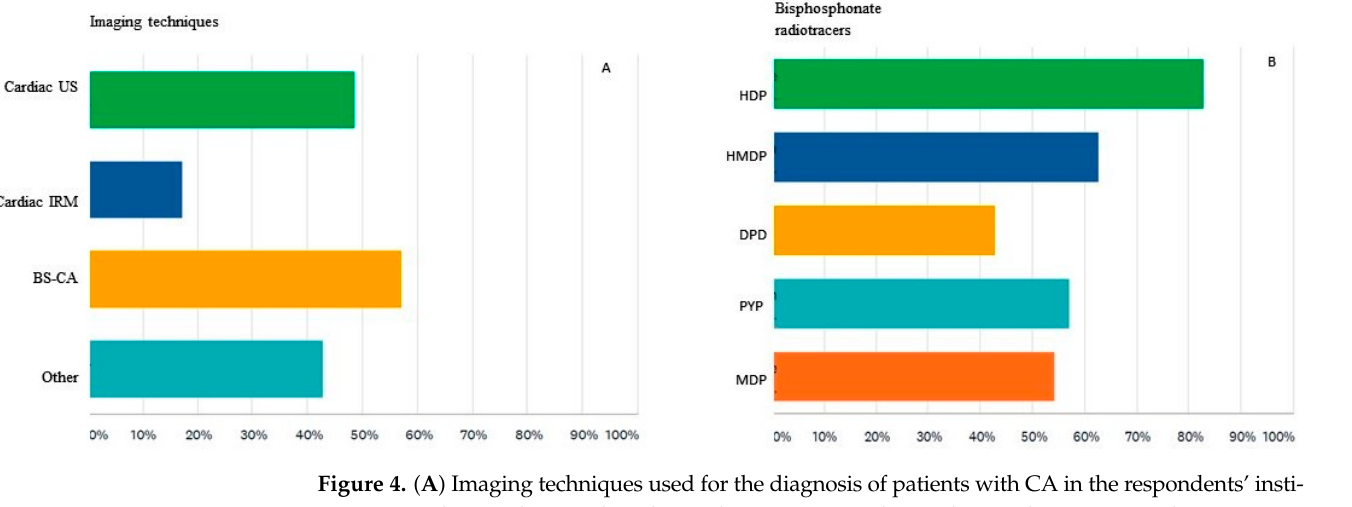
Figure 4. ( A ) Imaging techniques used for the diagnosis of patients with CA in the respondents’ institution or in the one they work with. Cardiac US = ecocardiography, Cardiac IRM = cardiac magnetic resonance imaging, Bone Scan = bisphosphonate scintigraphy for CA detection, Other = survey participants do not work or collaborate with a cardiology department. ( B ) 99mTc-labeled bisphosphonated radiotracers used in CA diagnosis. HDP = hydroxyethylene diphosphonate, HMDP = hydroxymethylene diphosphonate, DPD = 2,3-dicarboxypropane-1,1-diphosphonate, PYP = sodium pyrophosphate, MDP = methylene diphosphonate, NMPs = nuclear medicine physicians.